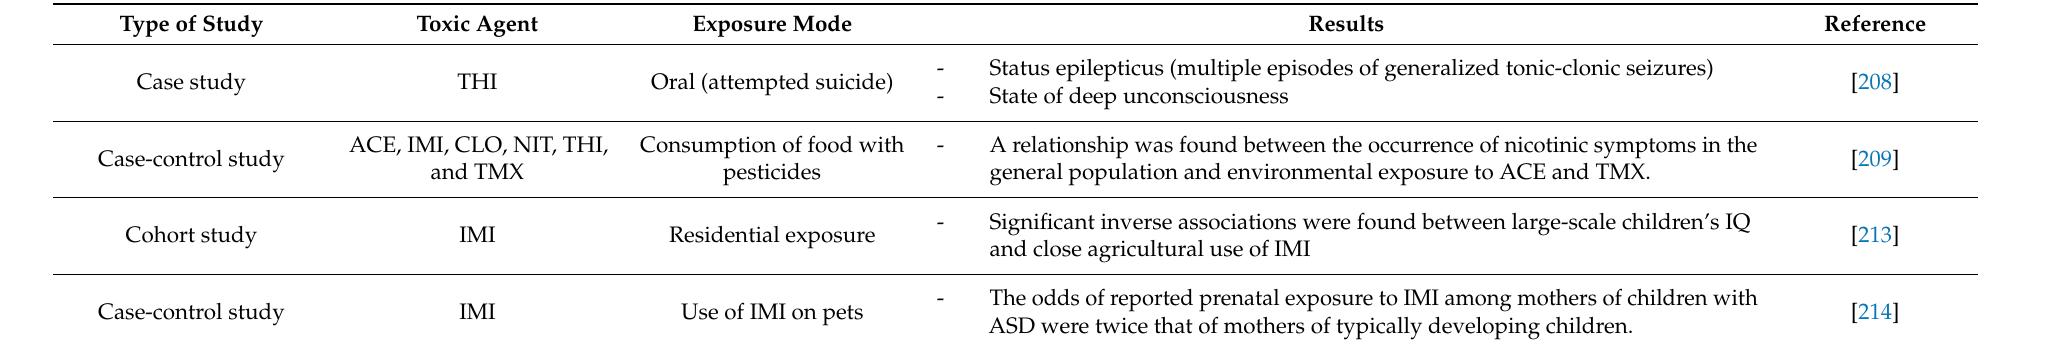
Table 4. Effects of exposure to neonicotinoid pesticides in